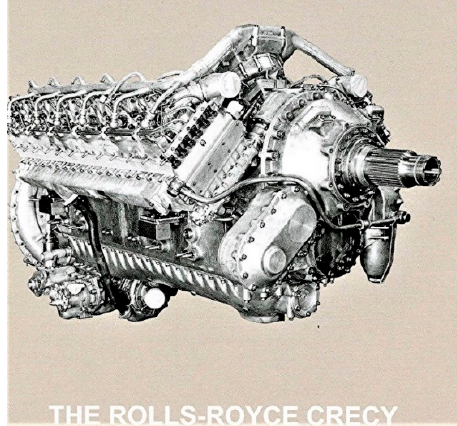
Figure 14. Rolls-Royce Crecy engine 12-cylinder two-stroke sleeve valve direct fuel injection 90 degree V aircraft piston engine. Reproduced with permission from WW2 aircraft.net Copyright Publisher,